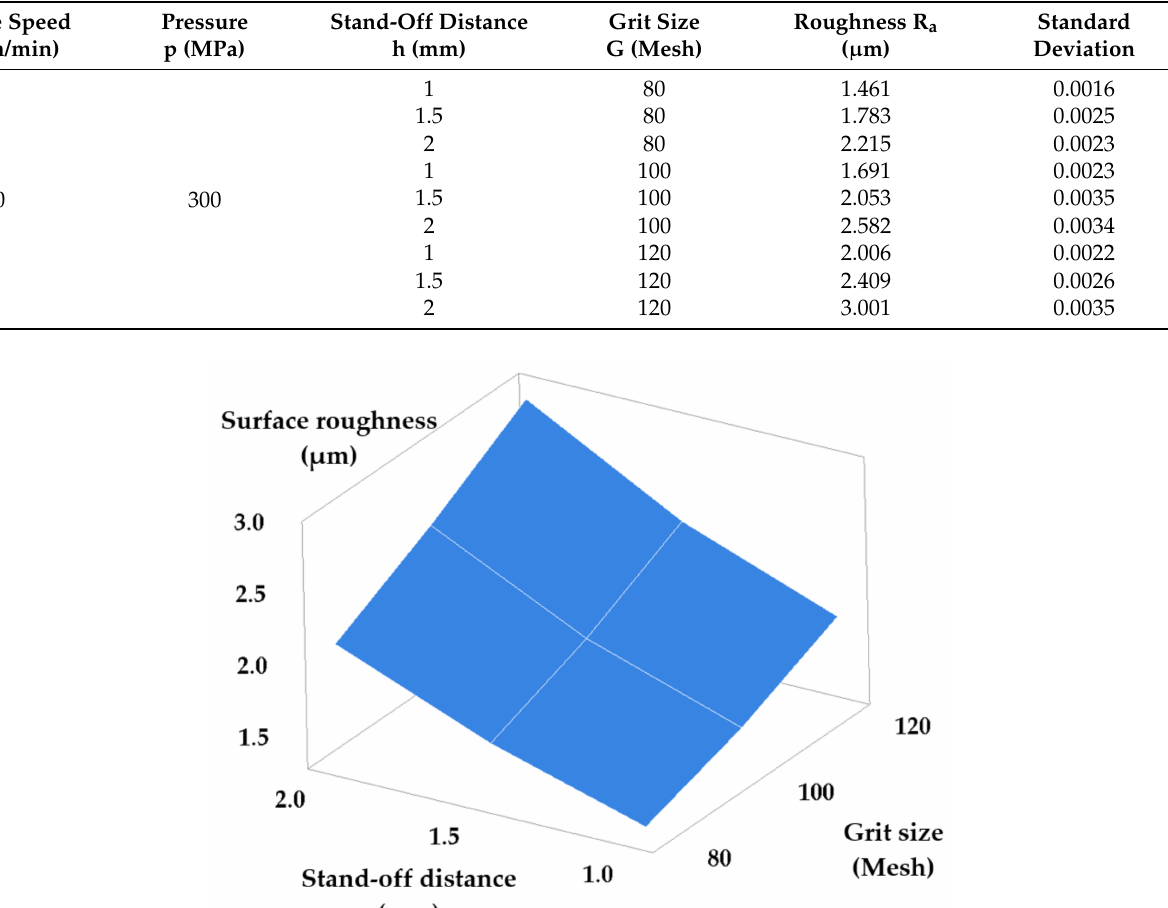
Table 7. Roughness values obtained upon adjusting stand-off distance and grit size.